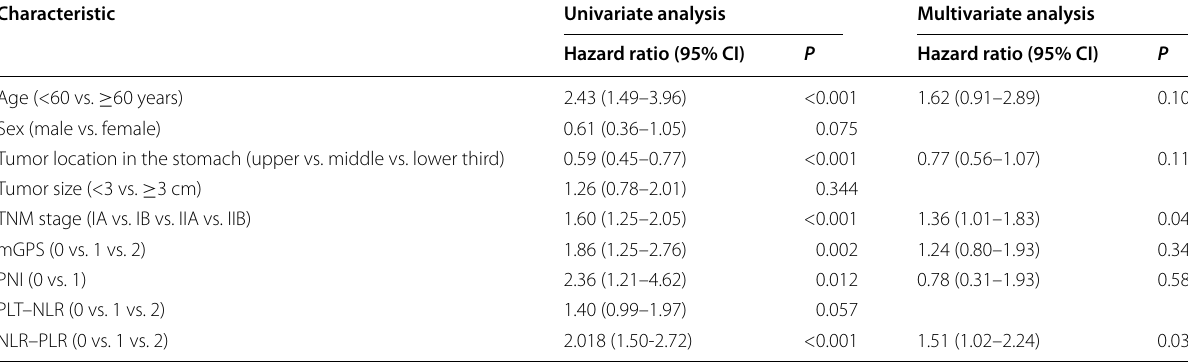
Table 3 Univariate and multivariate Cox regression analyses of overall survival in 305 patients with stage I–II gastric can- cer Characteristic